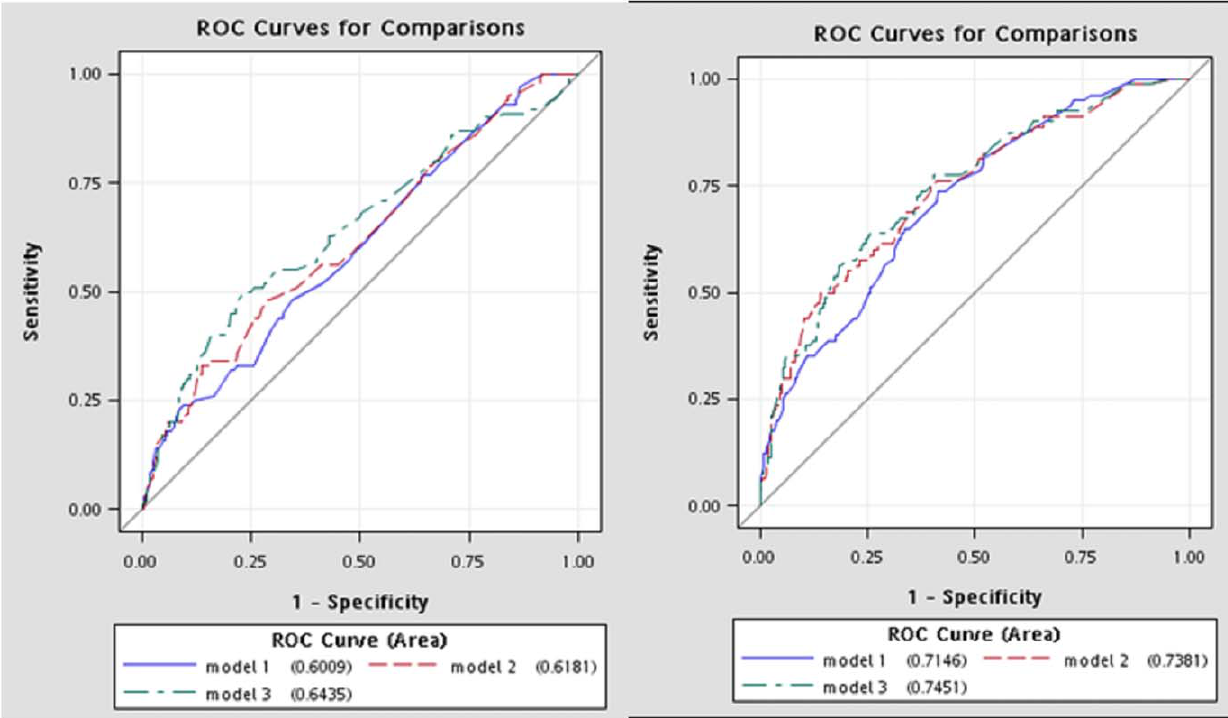
Figure 1. A—Comparing the AUCs of model 1, model 2, and model 3 in men. B—Comparing the AUCs of model 1, model 2, and model 3 in Women.